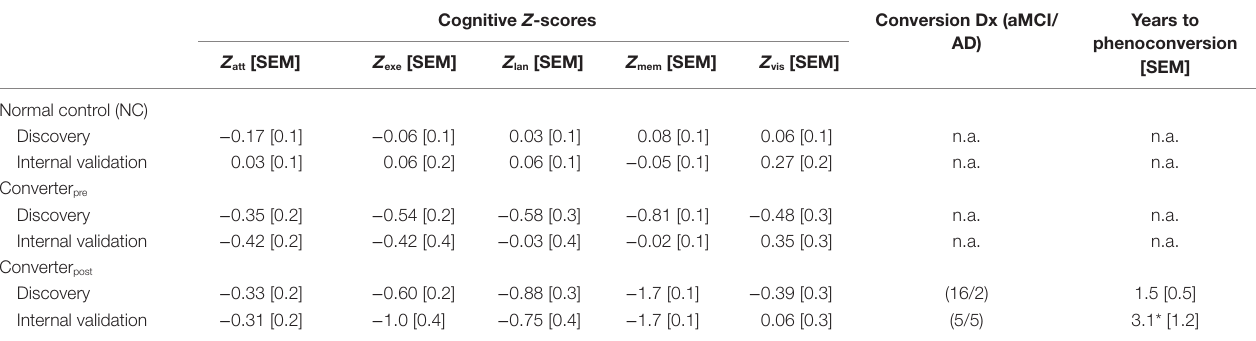
TaBle 2 | cognitive Z -scores and conversion diagnosis.